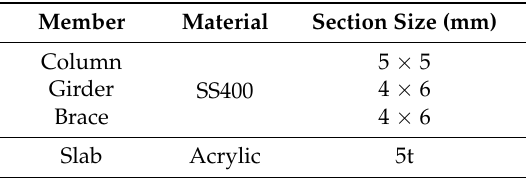
Table 1. Member properties of the scaled model.